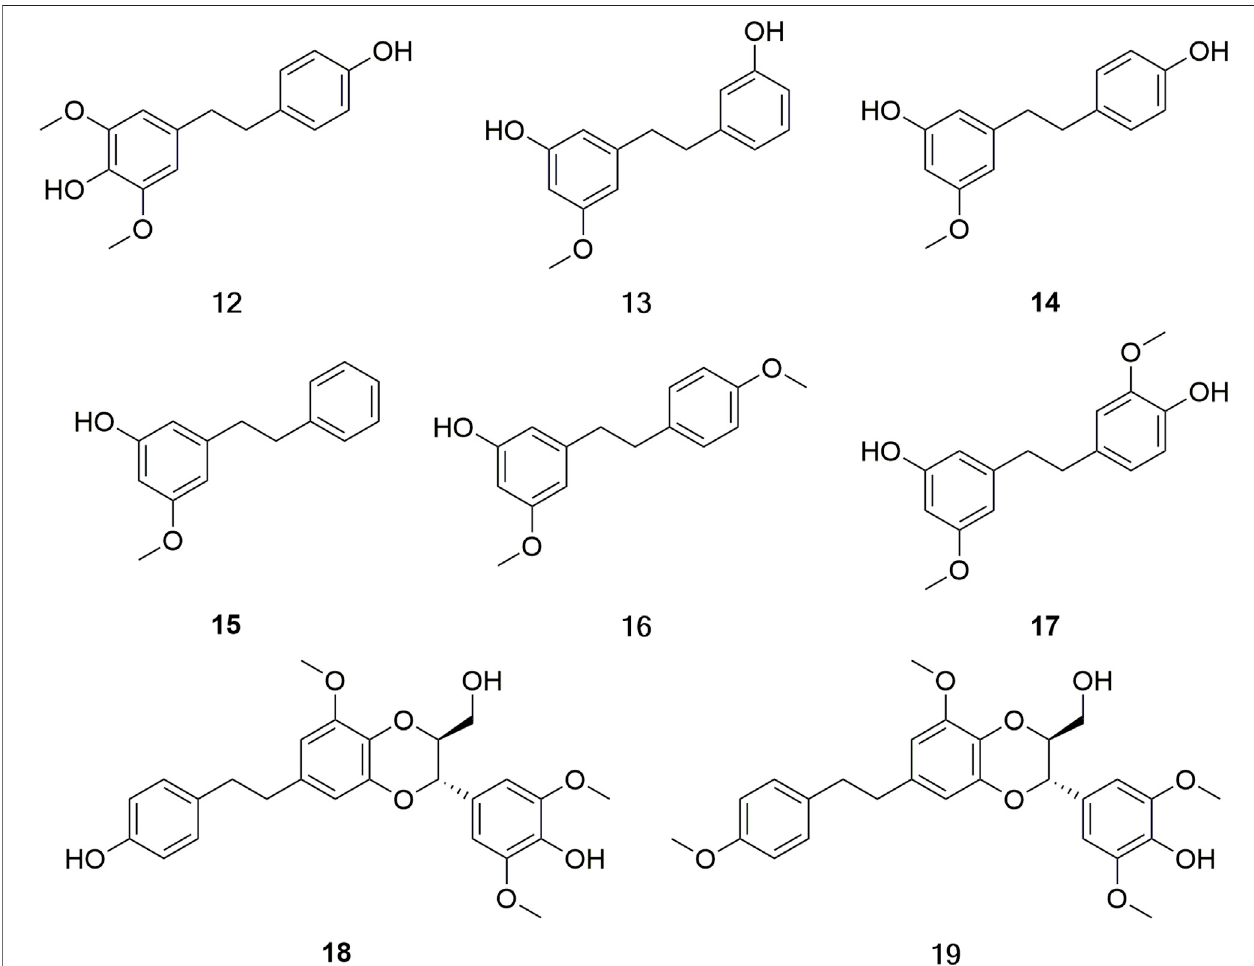
FIGURE 5 | Structure of bibenzyls ( 12 – 19 ) in D. huoshanense